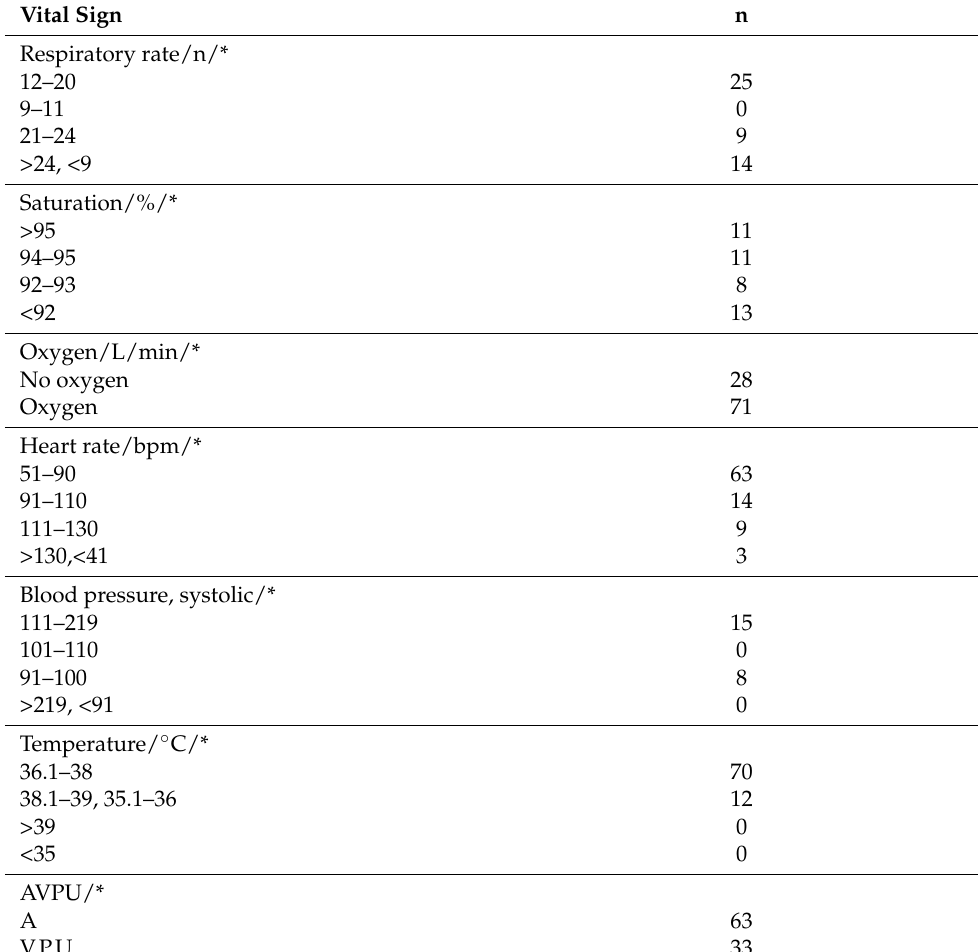
Table 2. Patients’ vital signs ( n =